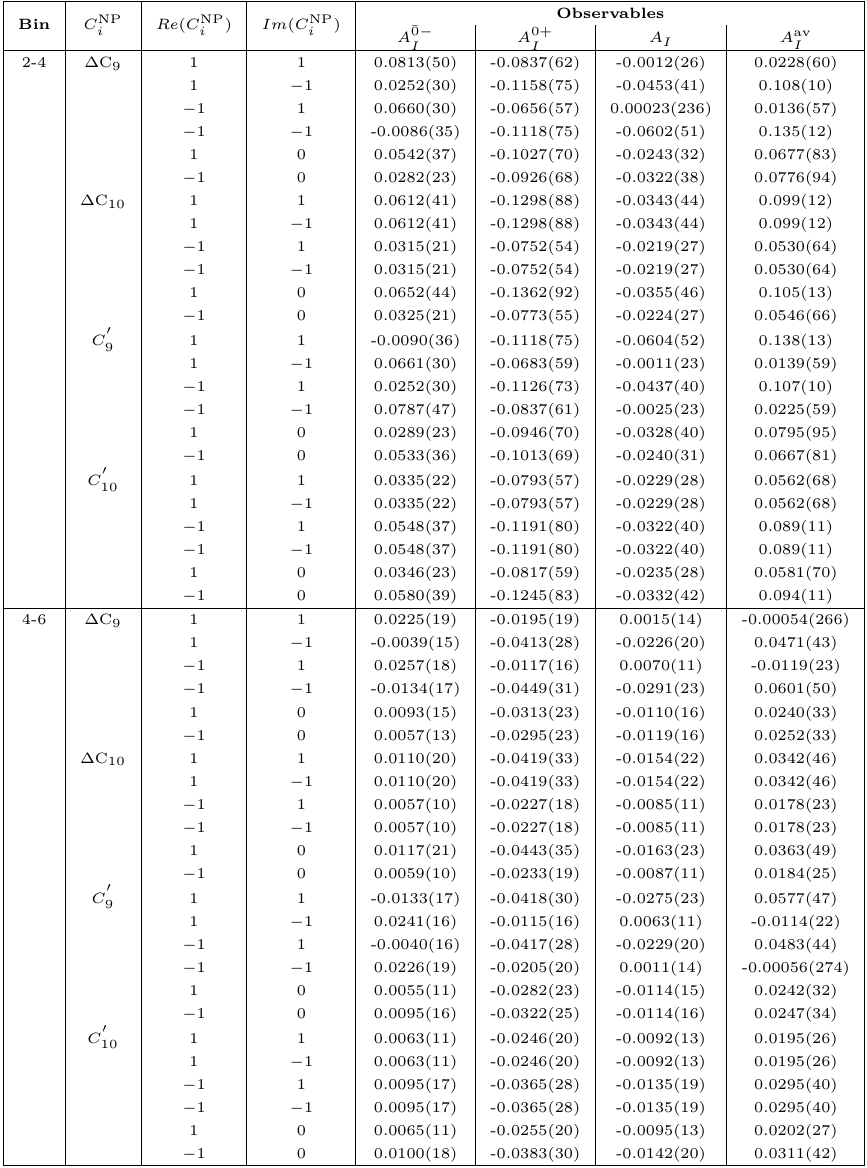
Table 47 . The dependence of the isospin observables corresponding to B → ρll on the real and imaginary parts of the NP WC’s ∆ C and C 0 for the q 2 bins 2 − 4 and 4 − 6 GeV 2 for a few 9 , 10 9 , 10 benchmark values of the real and imaginary parts of the corresponding